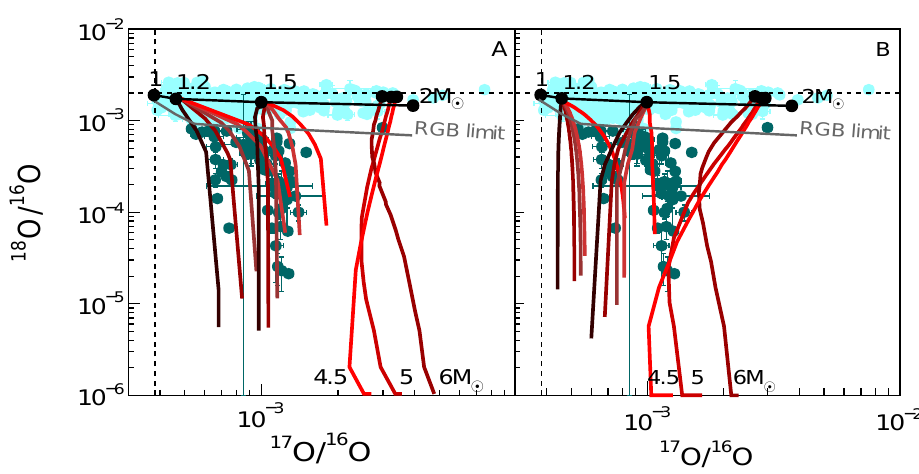
Figure 4. The 18 O/ 16 O vs. 17 O/ 16 O isotopic ratios in the envelope of solar metallicity stars at FDU (black solid line and markers) with mass from 1 to 2 M (cid:12) and at SDU for masses from 4.5 to 6 M (cid:12) , as indicated by the labels. Light cyan points are group 1 oxide grains, while darker dots are those of group 2. The red curves descending from the 1.2 M (cid:12) , and the 1.5 M (cid:12) markers refer to magnetic mixing model results for AGB stars for different values of k (see the text for details). The maximum modification of the envelope composition that can be produced by CBP during the RGB phase is indicated by the gray curve. Red curves starting from 4.5, 5, and 6 M (cid:12) SDU abundances deal with the evolution of 17 O/ 16 O and 18 O/ 16 O isotopic ratios in the envelope of AGB stars affected by HBB. Panel ( A ) refers to calculations run with reaction rates of set A and Panel ( B ) to calculations run with the set B. The dashed lines mark the 17 O/ 16 O and the 18 O/ 16 O solar